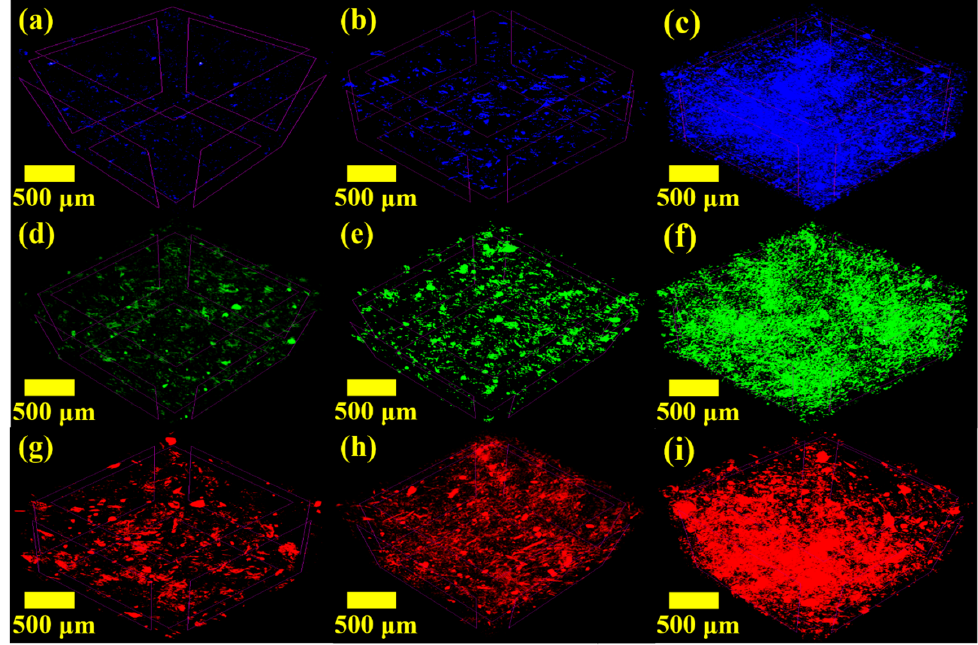
Figure 4. Micro-CT images of the composites with M5 ( a ) 10 wt.%, ( b ) 20 wt.%, and ( c ) 30 wt.%; M15 ( d ) 10 wt.%, ( e ) 20 wt.%, and ( f ) 30 wt.%; and M25 ( g ) 10 wt.%, ( h ) 20 wt.%, and ( i ) 30 wt.%.